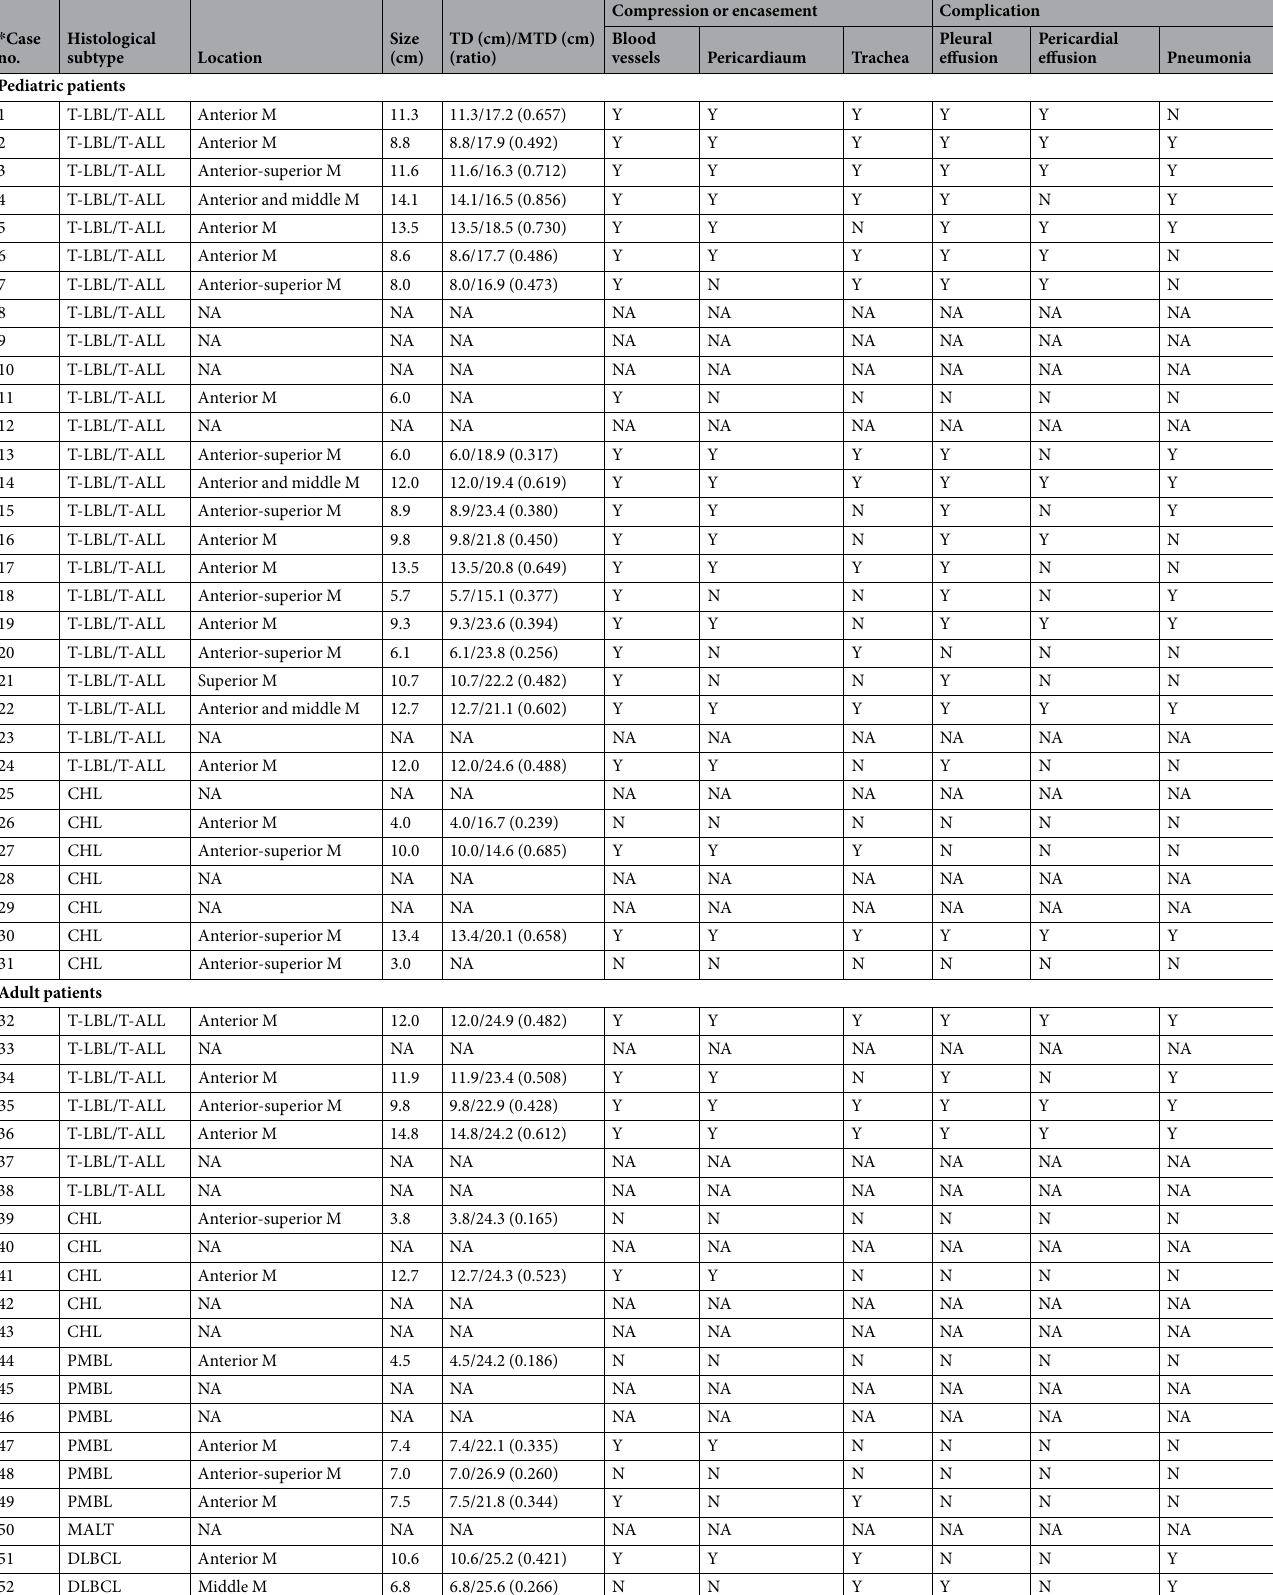
Table 4. Radiological characteristics of 52 cases with lymphomas involving the mediastinum. Abbreviations: M, mediastinum; NA, not available; N, no; Y, yes. * Case numbers are identical with the patient number used in Table